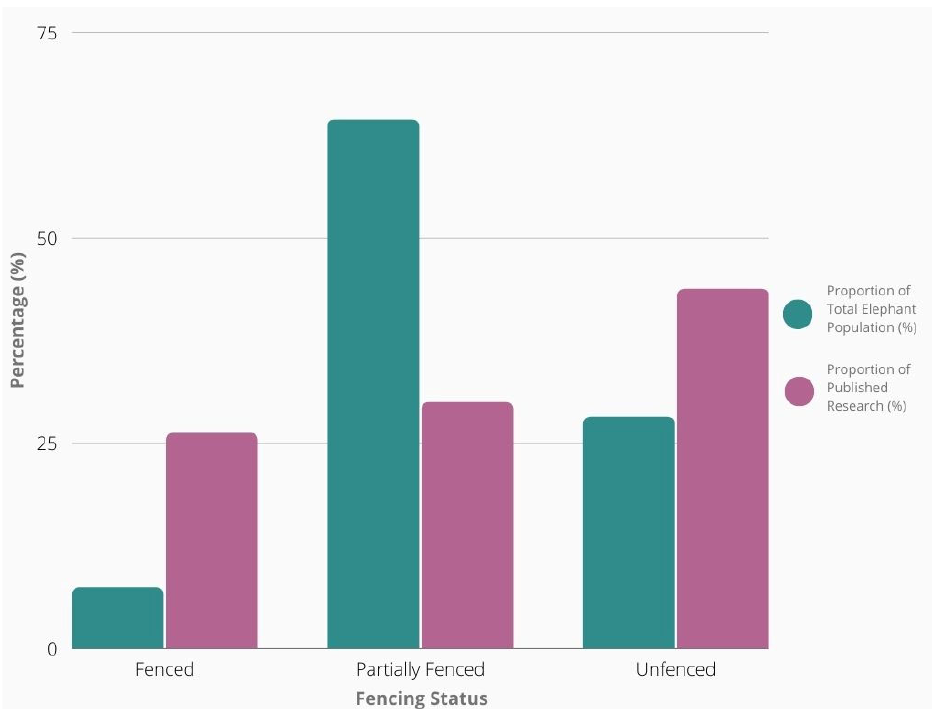
Figure 4. Percentage of research versus proportion of elephant population occurring in fenced, partially fenced and unfenced reserves (PAs).